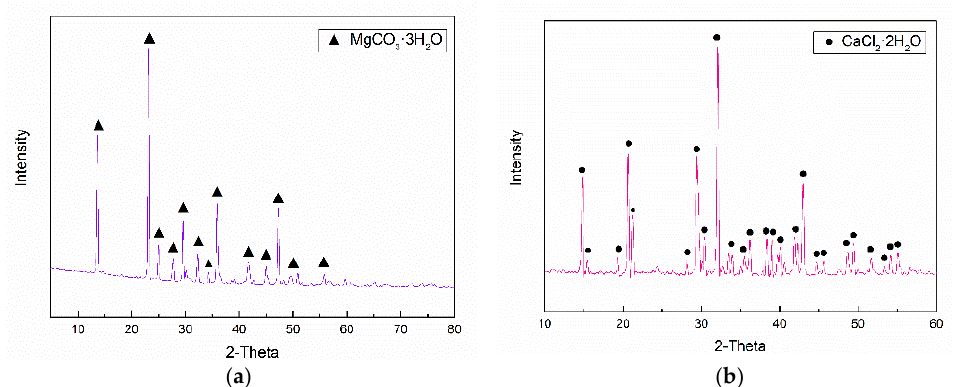
Figure A2. XRD patterns of ( a ) MgCO 3 ·3H 2 O and ( b ) CaCl 2 ·2H 2 O.